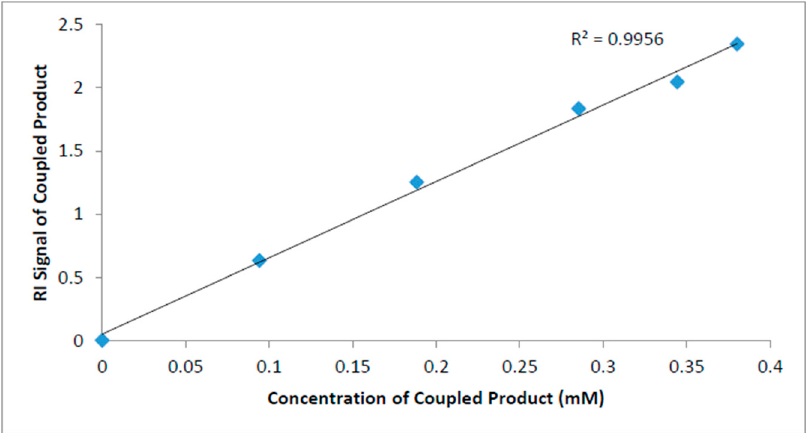
Figure 4. RI signal of GPC-RI detector (Wyatt T-rEX) of M p assigned to “coupled” peak of polymer mixture (nominal molecular weights 2500 and 5000 Da), as a function of concentration in the mixture injected into GPC.